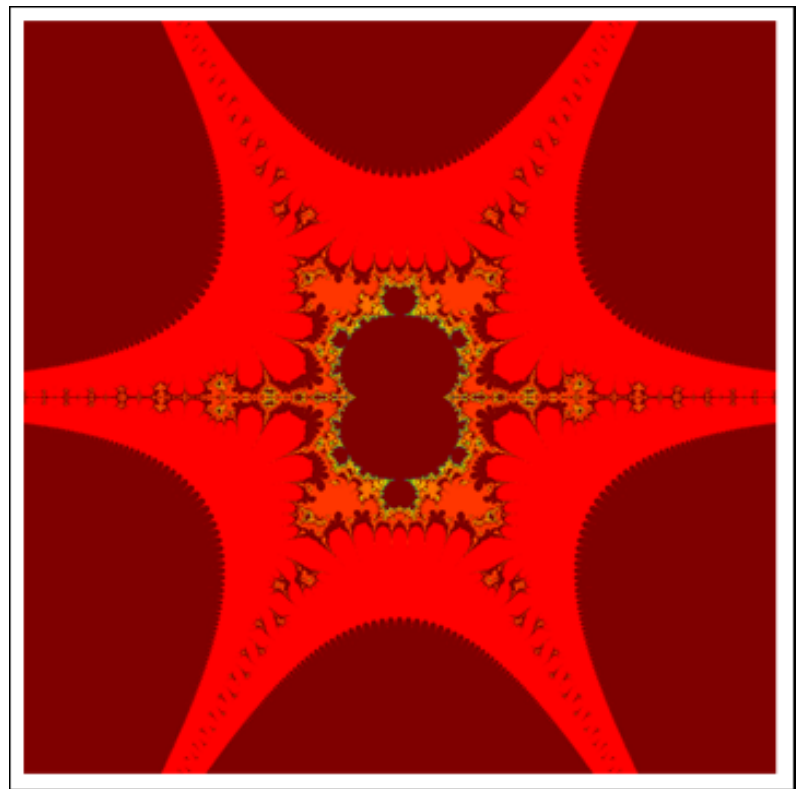
Figure 20. M-set for τ ( z ) = sin ( z 3 ) + c via DKIS. The image execution time is 1030.53 s.